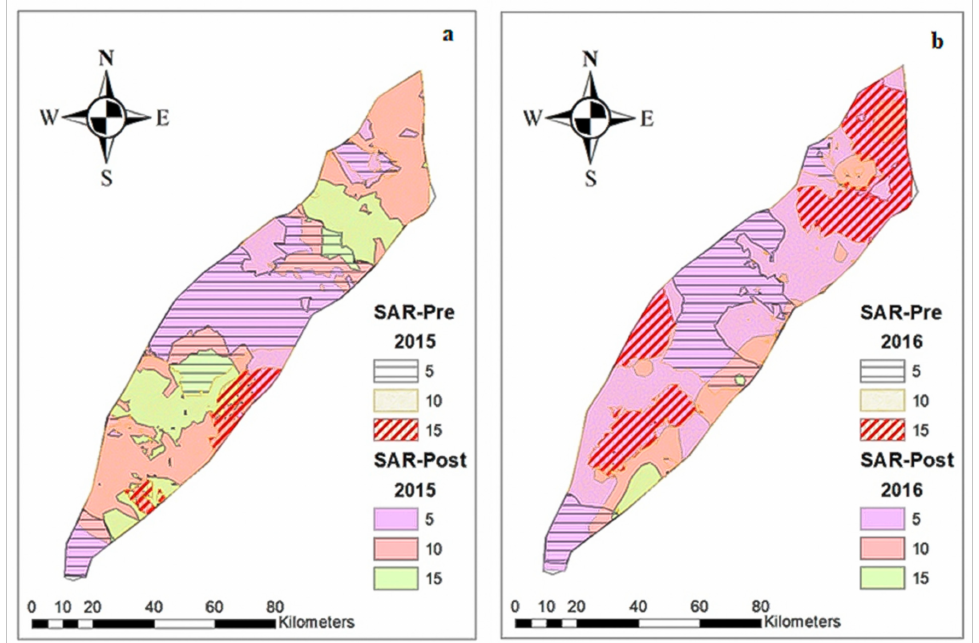
Figure 7. Overlay analysis of groundwater SAR. ( a ) SAR for 2015, ( b ) SAR for